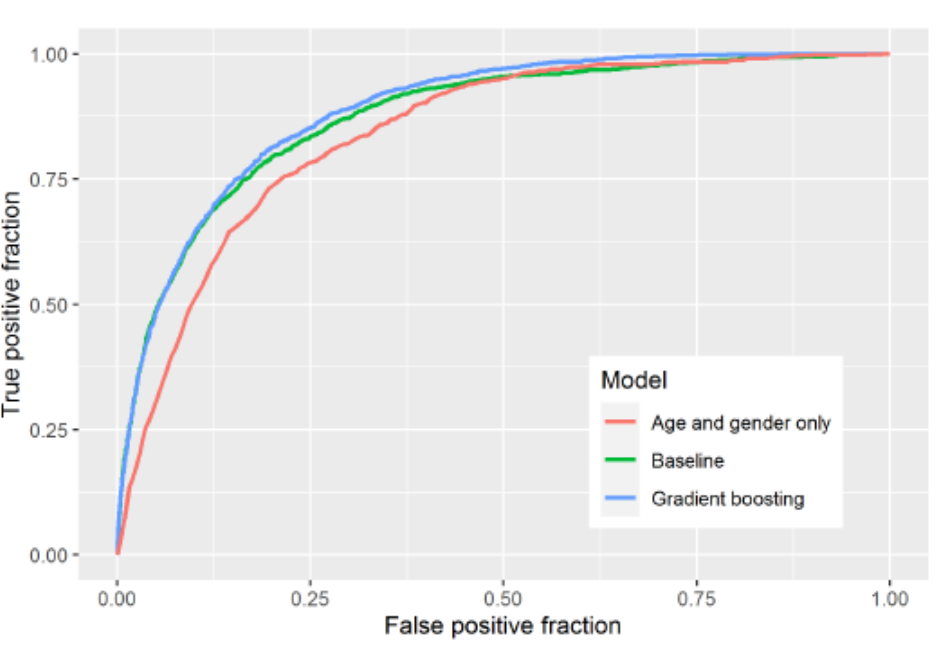
Figure 4. Adapted from [20], the figure shows a set of ROC curves for gradient boosting and logistic regression